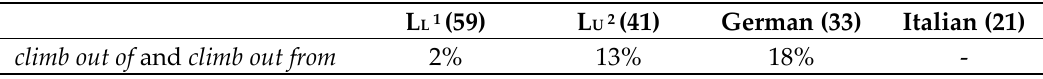
Table 8. Group comparison of the use of climb out of and climb out from in the frog-leaves-jar